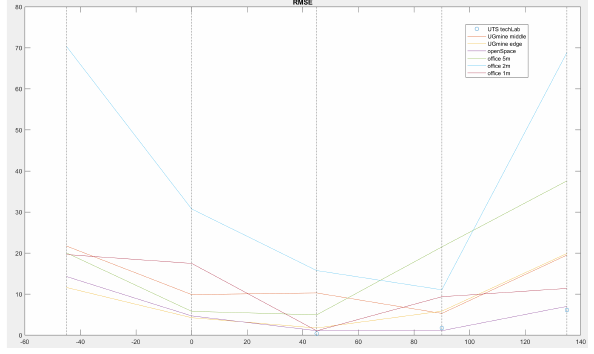
Figure 16 . The result of RMSE for all testing environments and